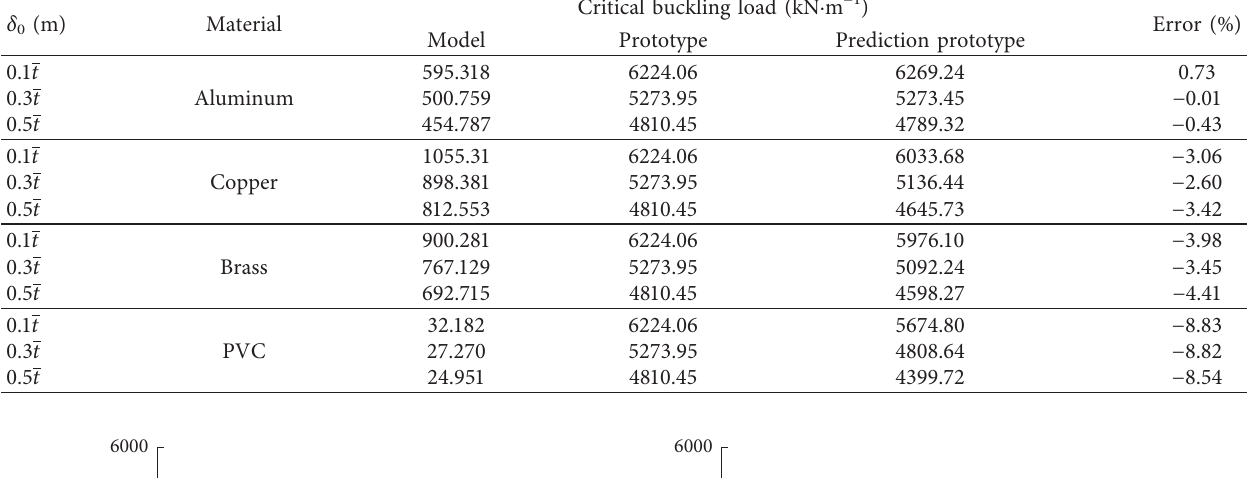
Table 7: Partial similitude simulation of axial compression nonlinear buckling of the longitudinal-ring rectangular stiffened cylindrical shell.